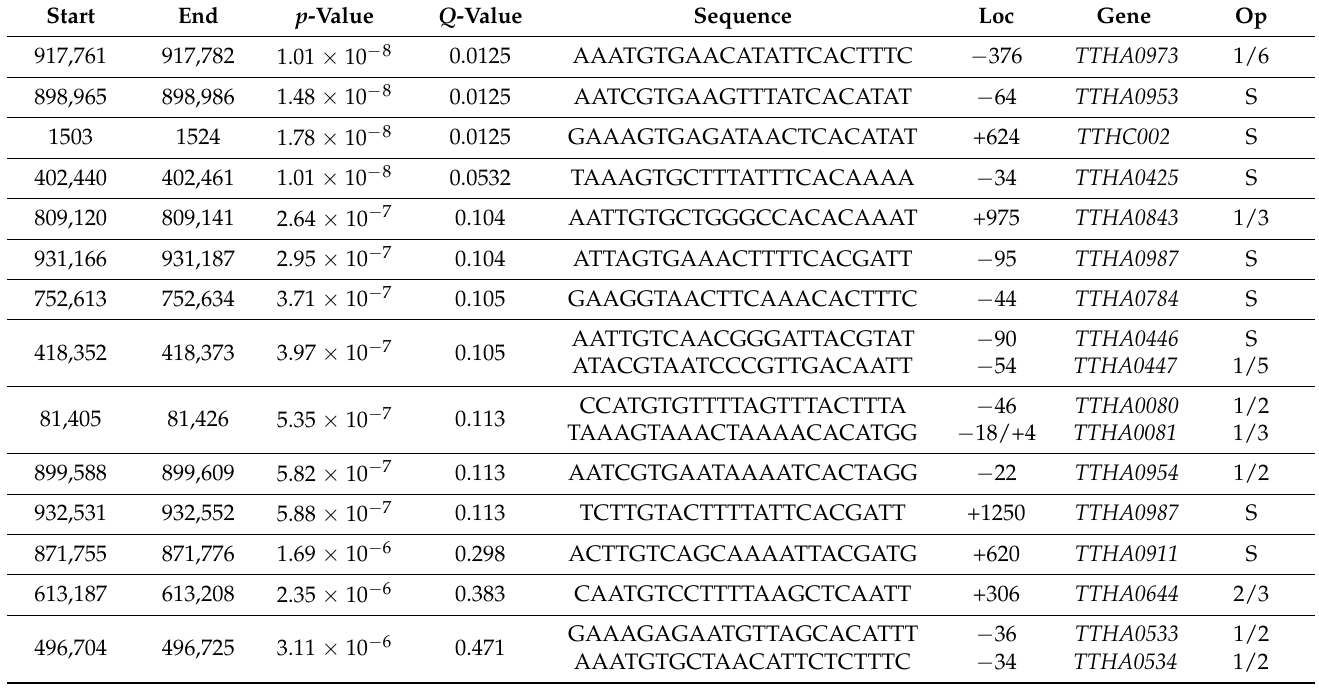
Table 2. TTHA1359-consensus sequences mapped in the genome of T. thermophilus